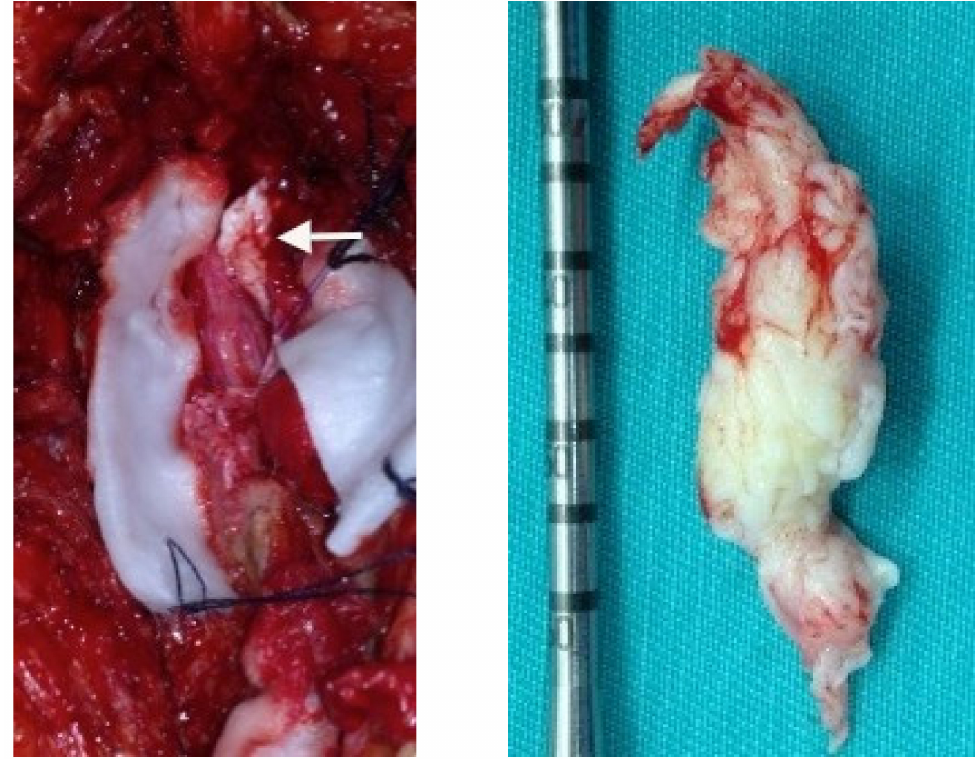
Figure 2. Intradural lumbar disc herniation ( white arrow